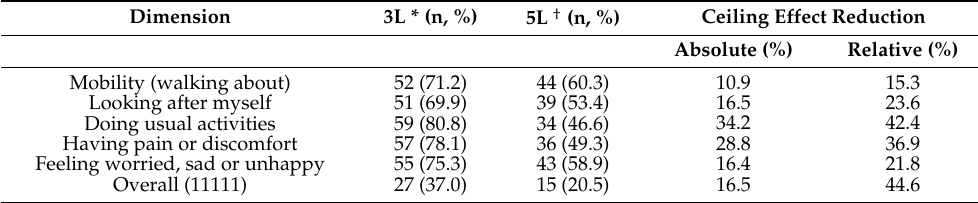
Table 3. Proportions of “no problems” responses for the EQ-5D-3L-Y and EQ-5D-5L-Y systems and ceiling effect